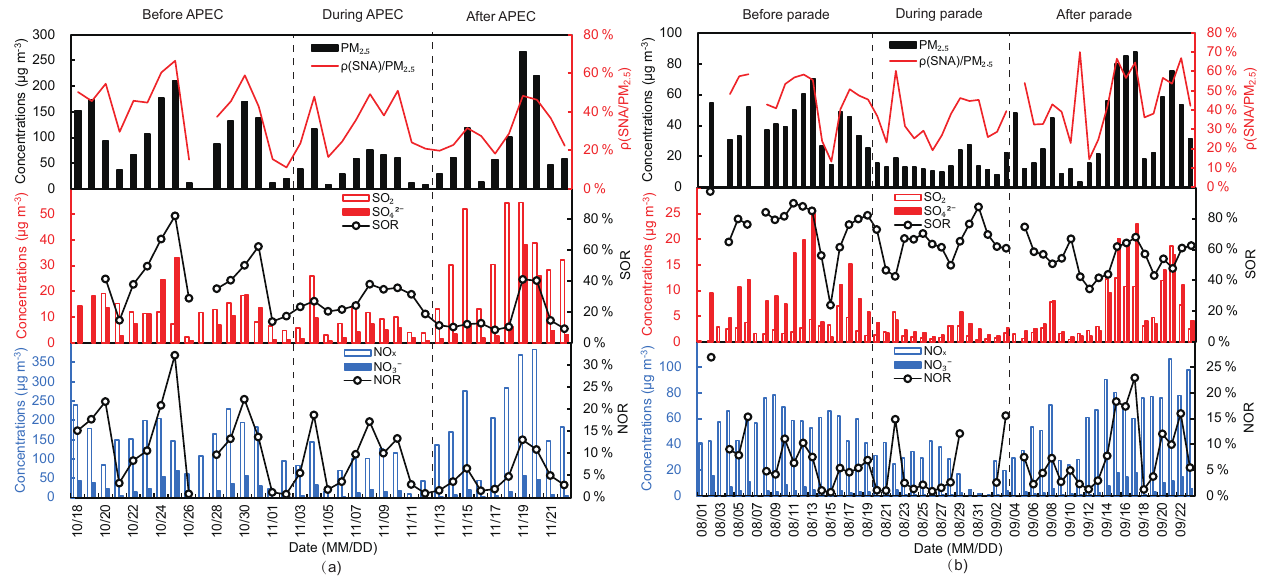
Figure 4. Upper panel: time series of the proportion of sulfate, nitrate, and ammonia (SNA) in PM 2 . 5 ( ρ ; SNA / PM 2 . 5 ) and PM 2 . 5 mass concentrations (the black bar represents PM 2 . 5 concentration and the red line represents ρ ; SNA / PM 2 . 5 ). Middle panel: SO 2 , SO 2 − , and 4 SOR ([SO 2 − ] / ([SO 2 ] + [SO 2 − ])). Lower panel: NO x , NO − , and NOR ([NO − ] / ([NO x ] + [NO − ])). Data collected during the (a) APEC 4 4 3 3 3 2014 and (b) Victory Parade 2015 campaigns. The hollow bars represent gaseous pollutants (red for SO 2 , blue for NO x ), and solid bars represent secondary inorganic ions (red for sulfate, blue for nitrate).